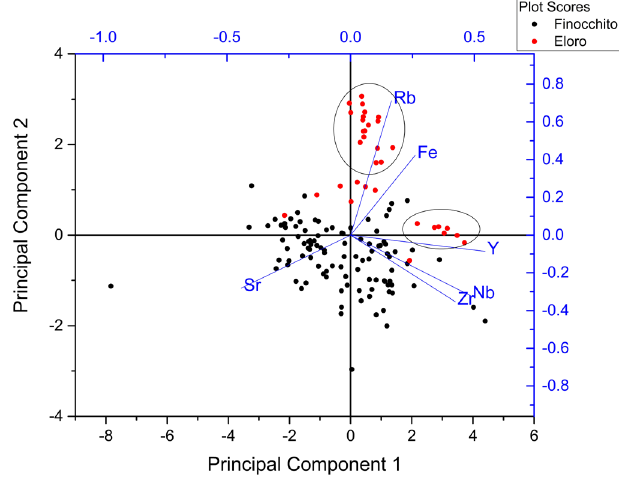
Figure 2. Scatterplot showing the ceramic groups from Monte Finocchito and Helorus.